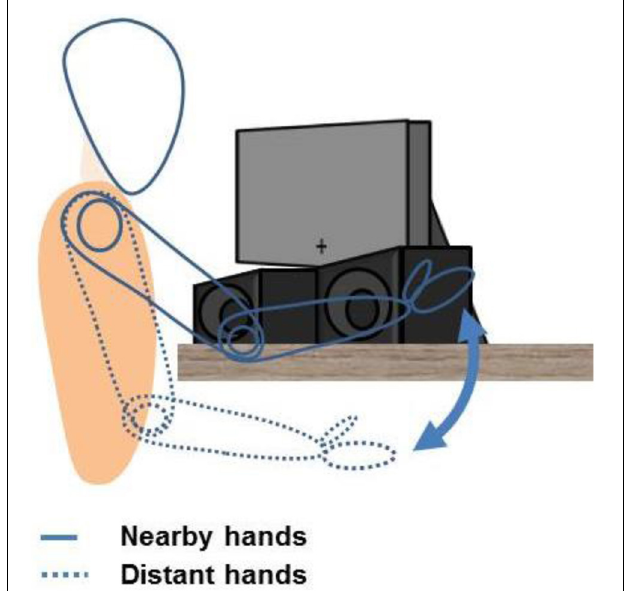
FIGURE 1 | Apparatus and setup of all experiments. Participants placed their hands either on their lap or on the table by the speakers, with the distance between hands (approx. 40cm) fixed by a platform (not shown). Hands are placed vertically to mimic a power grasp. A fixation cross is displayed at the onset of each trial, allowing both speakers (and hands, in the hands-near condition) to remain